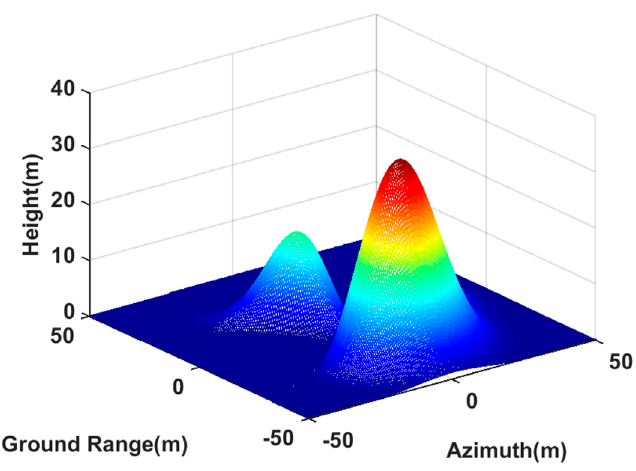
Figure 5. The 3D deceptive scene.